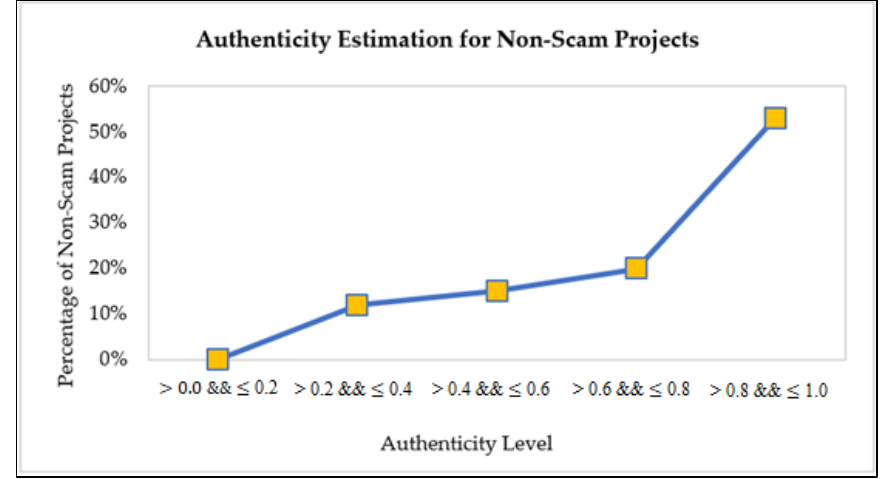
Figure 8. Authenticity estimation for Non-Scam projects.